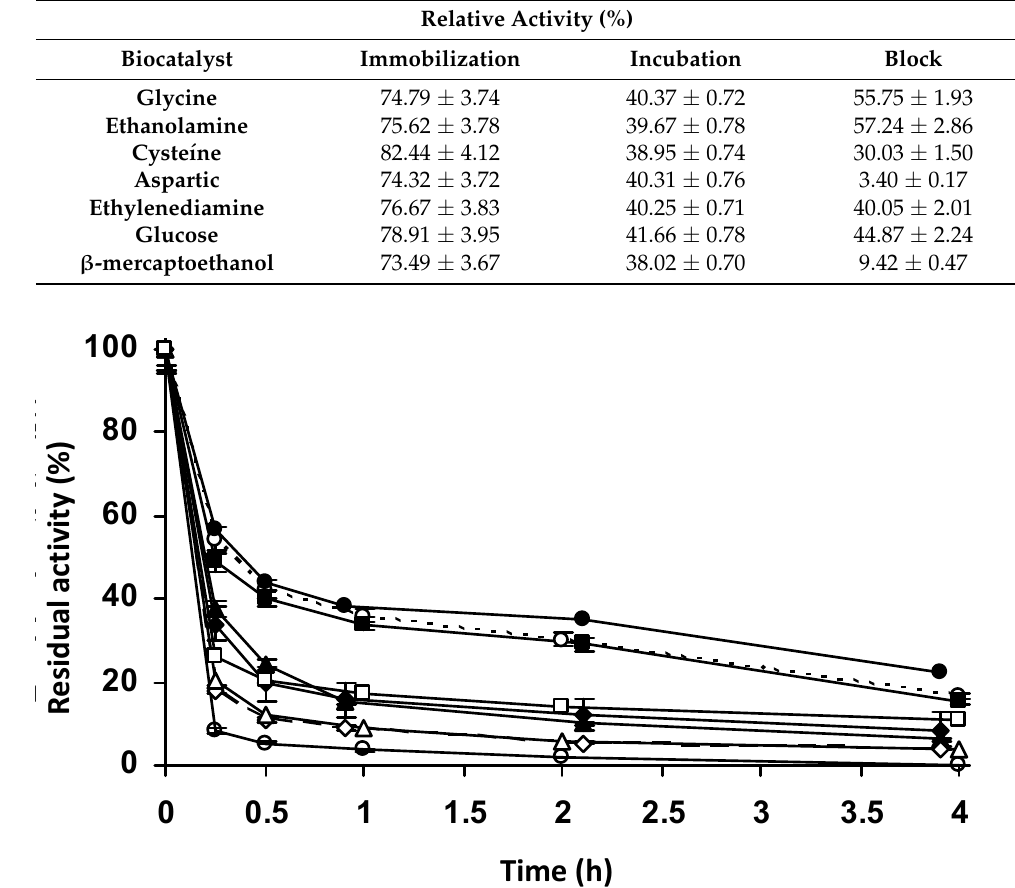
glucose, aspartic and β -mercaptoethanol were also acquired from Merck. Sepharose ®